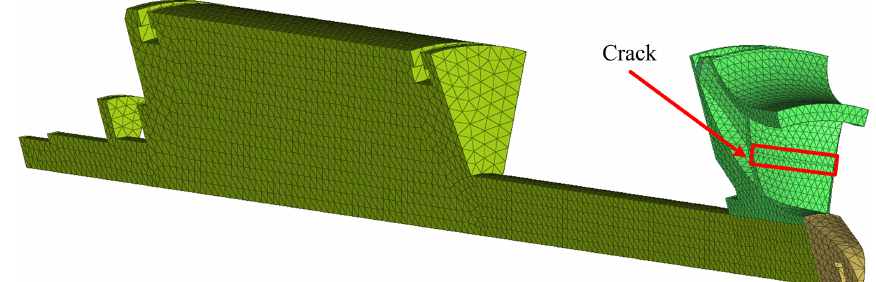
Figure 12. Finite-element model of the impeller-shaft assembly.